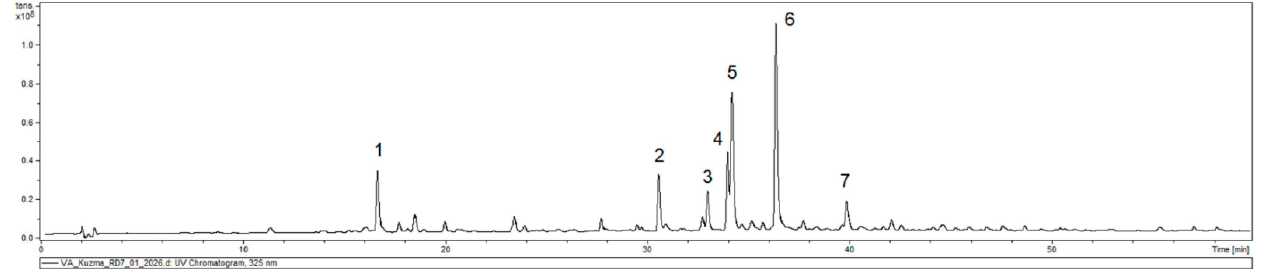
Figure 1. The chromatogram of the qualitative UHPLC-DAD-ESI-MS analysis of V. amygdalina methanolic leaf extract. Key: Compound 1 = 5- O -caffeoylquinic acid, Compound 2 = luteolin hexoside, Compound 3 = 3,4- O -dicaffeoylquinic acid, Compound 4 = 1,5- O -dicaffeoylquinic acid, Compound 5 = 3,5- O -dicaffeoylquinic acid, Compound 6 = 4,5- O -dicaffeoylquinic acid, Compound 7 = luteolin dihexoside. Table 1. UPLC-DAD-ESI-MS data of detected and identified polyphenolic compounds in V. amyg- dalina methanolic leaf extract.